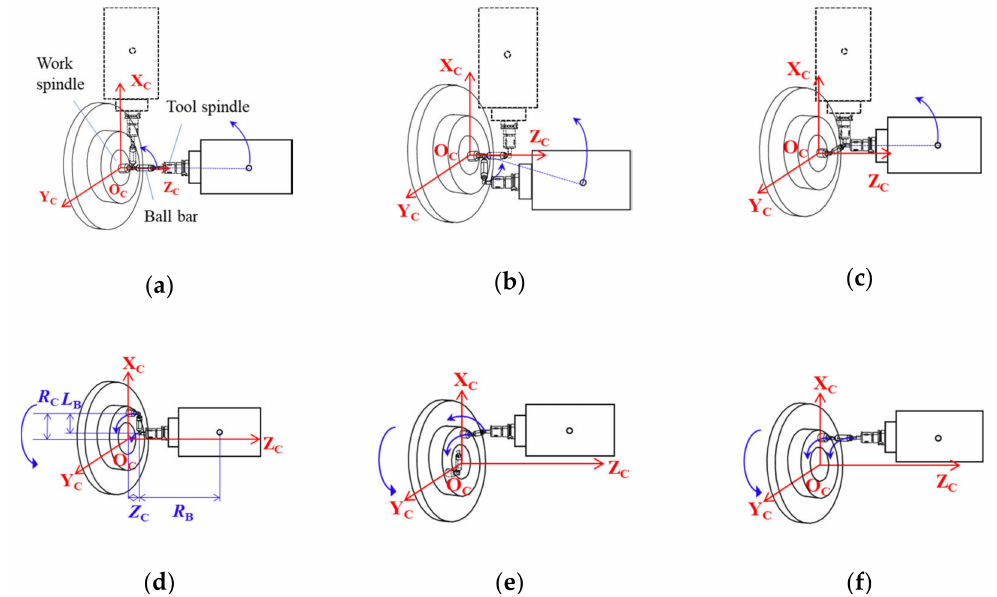
Figure 4. ( a ) B axis radial measurement; ( b ) B axis tangential measurement; ( c ) B axis axial measurement; ( d ) C axis radial measurement; ( e ) C axis tangential measurement; ( f ) C axis axial measurement.